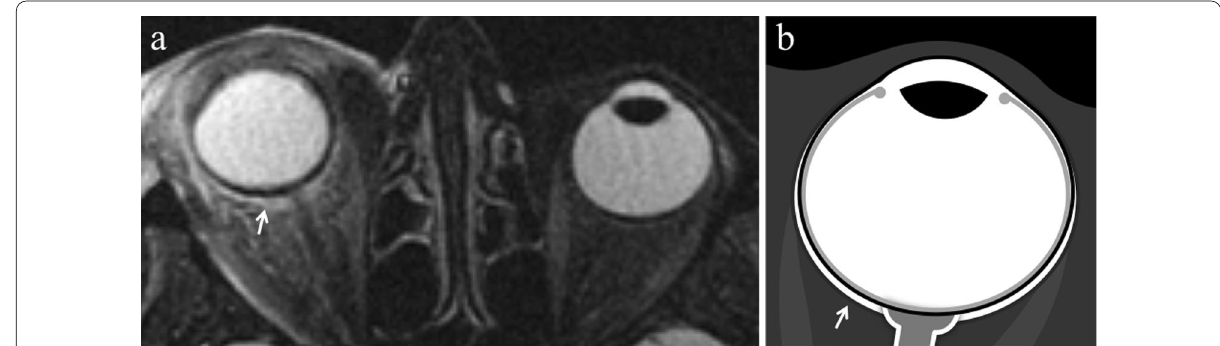
Fig. 5 A 91-year-old woman with orbital cellulitis and endophthalmitis of the right eye. ( a ) Axial T2-weighted turbo spin-echo STIR image displays a fluid collection, adjacent to the posterior outer edge of the sclera of the right eye, filling the Tenon’s space (white arrow). Note the edematous thickening of the periocular tissues and exophthalmos. ( b ) Corresponding schematic drawing illustrates the anatomic location of the episcleral (Tenon’s) space (white arrow)